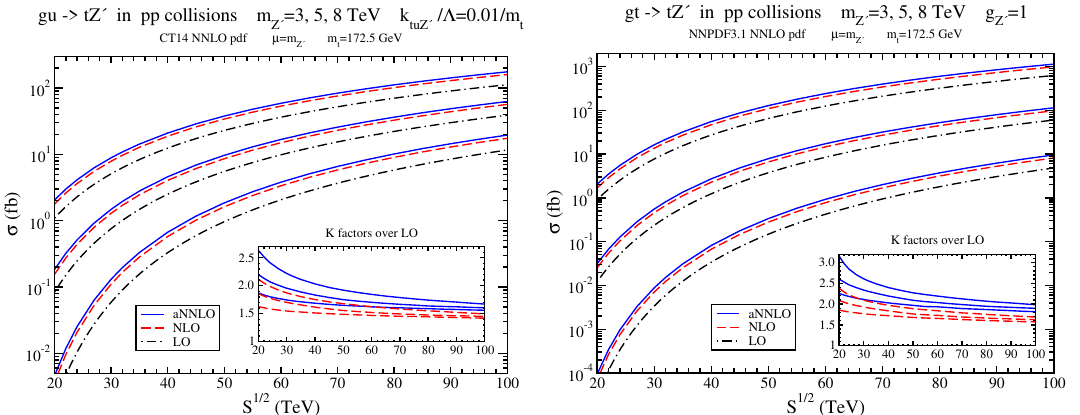
Figure 4: Cross sections vs. collider energy for tZ (cid:48) production via anomalous t - u - Z (cid:48) couplings (left) and via initial-state tops (right).